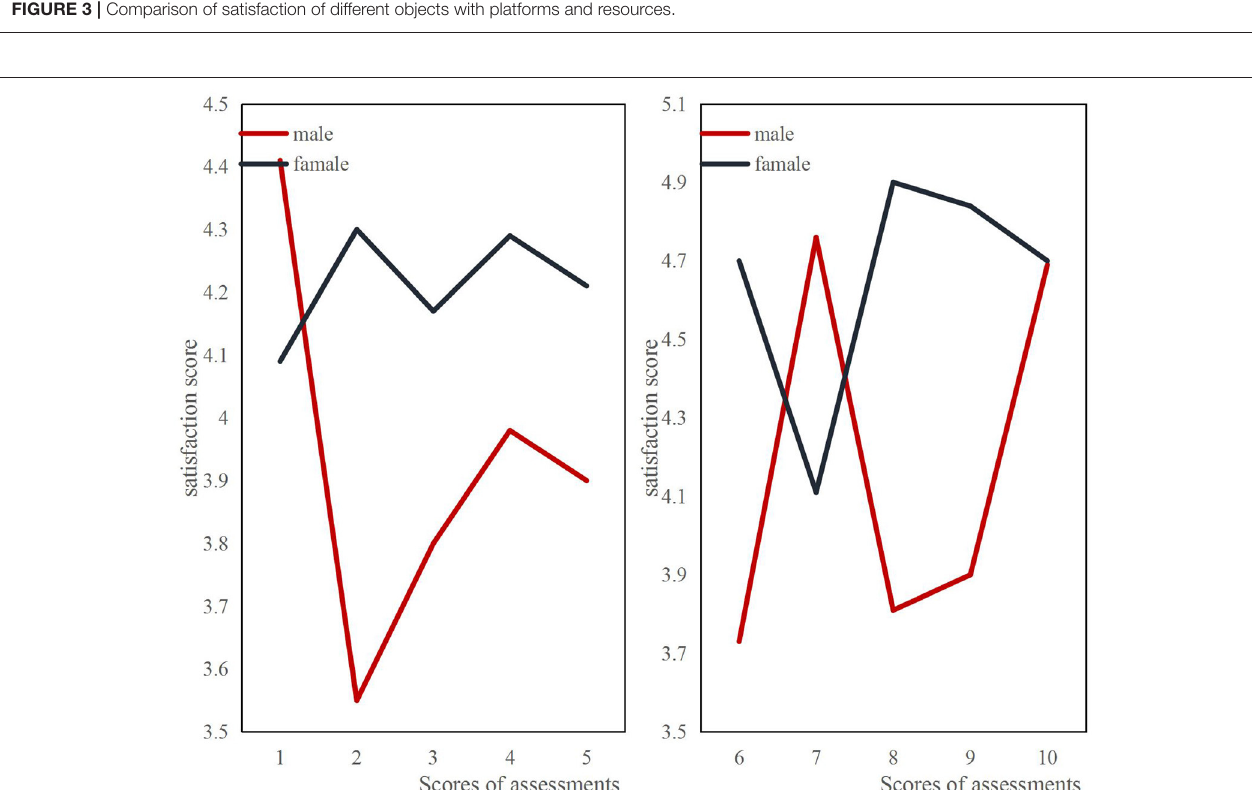
FIGURE 4 | Comparison of male and female students’ satisfaction with teaching